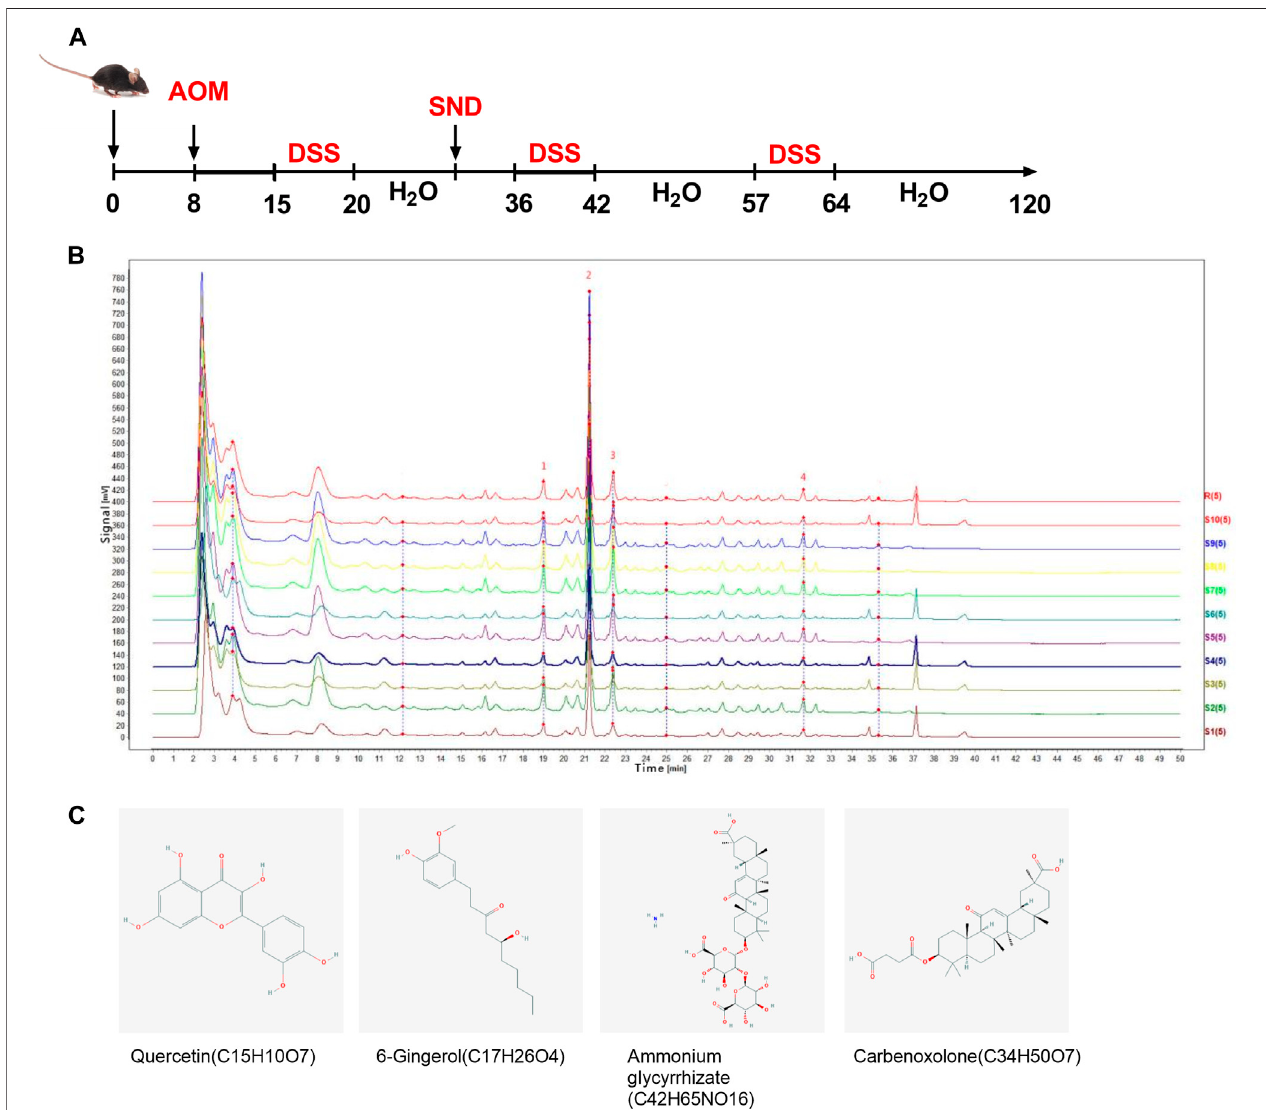
FIGURE1| Experimentalprotocolandphytochemicalanalysis. (A) Animalexperimentdesign. (B) HPLCchromatogramofSNDrecordedat254 nm.Peaksoffour primary ingredients, including (1)Quercetin, (2)Ammonium glycyrrhizate, (3)6-Gingerol, and (4)Carbenoxolone, are shown. (C) Structures of the four active ingredients.